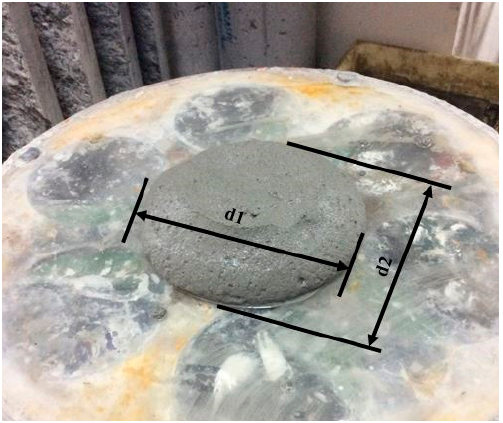
Figure 4. Mortar workability test measurement process.